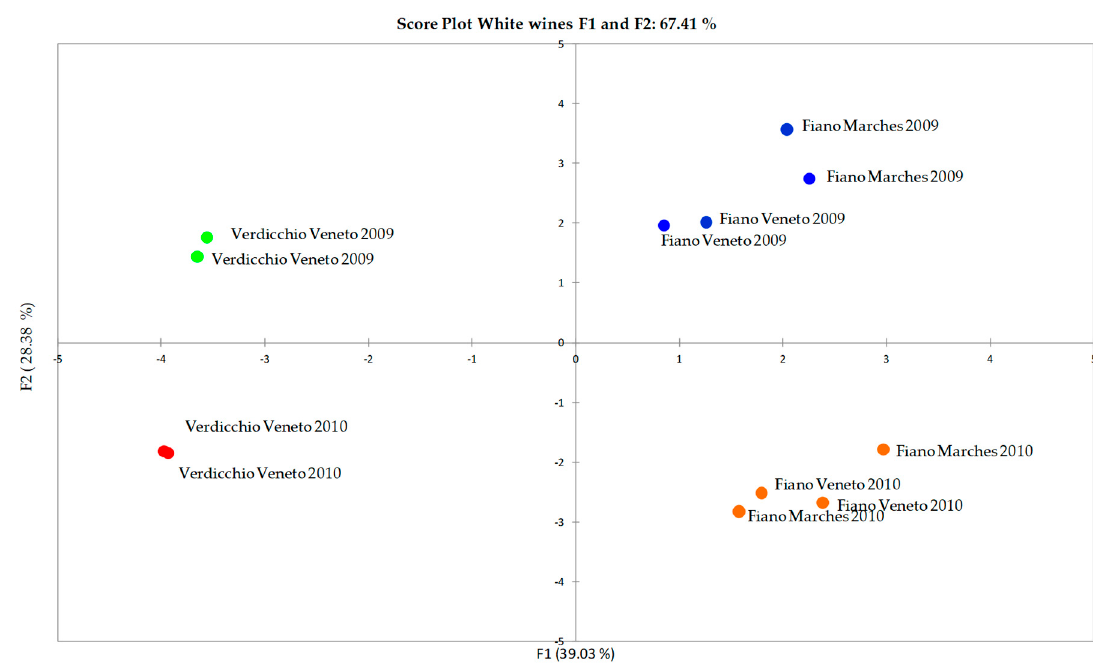
Figure 3. Score plot for white wines (Verdicchio and Fiano) in the two vintages (2009–2010).